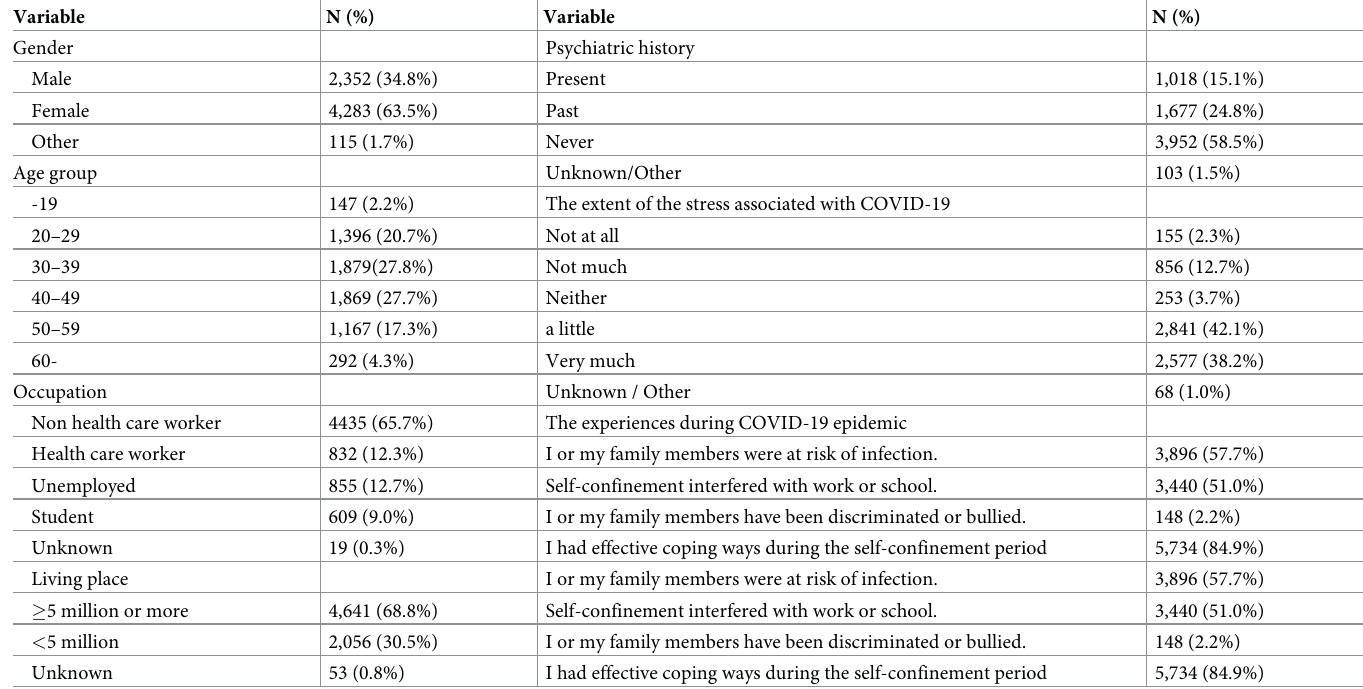
Table 1. Characteristics of respondents.